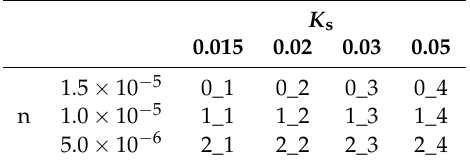
Table 2. Parflow ensemble members and their